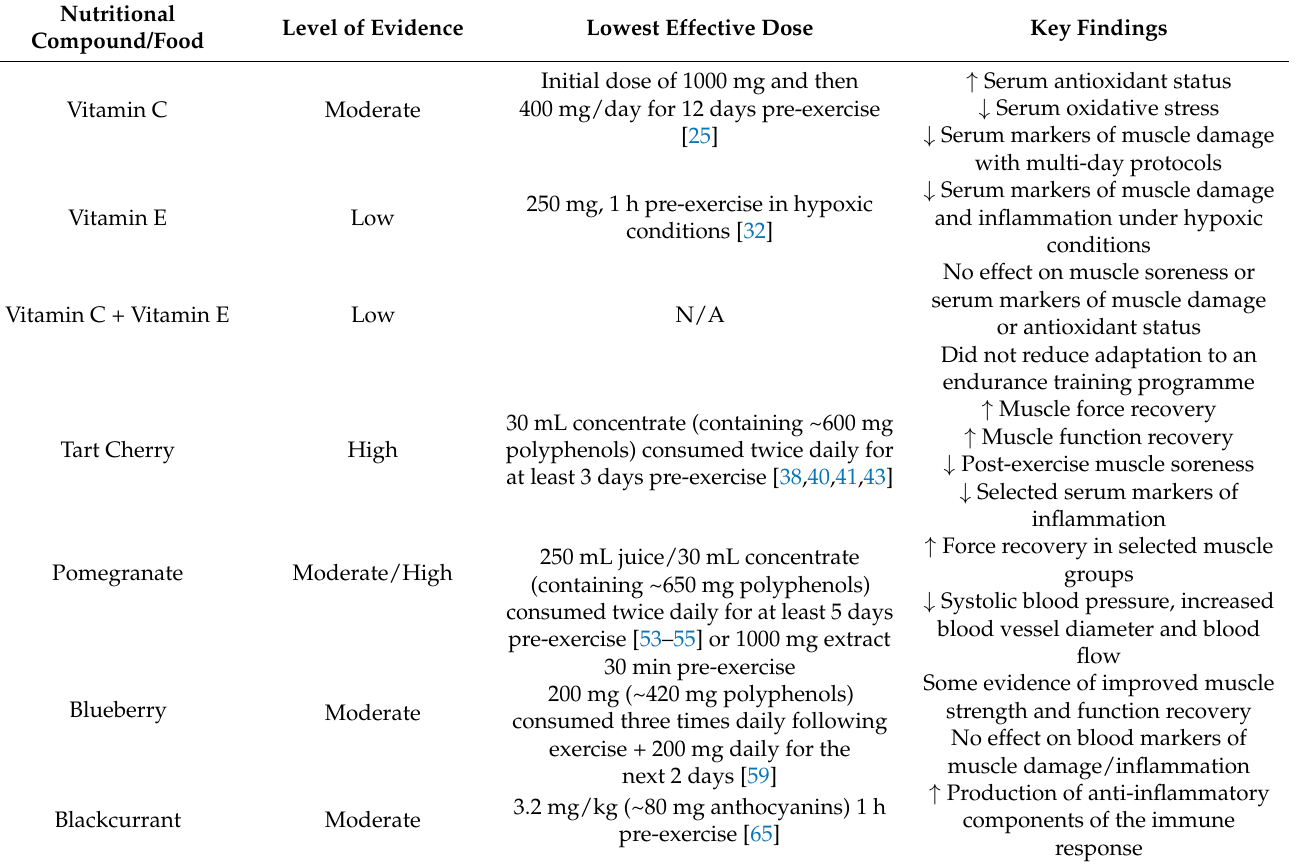
Table 1. Effects of nutritional compounds on aspects related to post-exercise